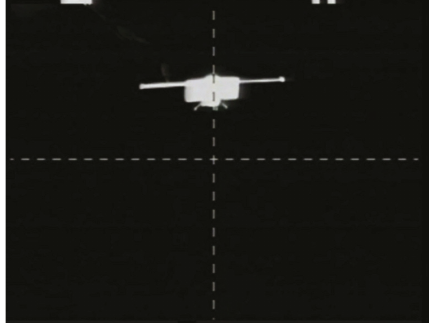
Figure 10: The frame from the video of “ Chibis-M ” separation from the cargo spaceship “ Progress-13M. ”